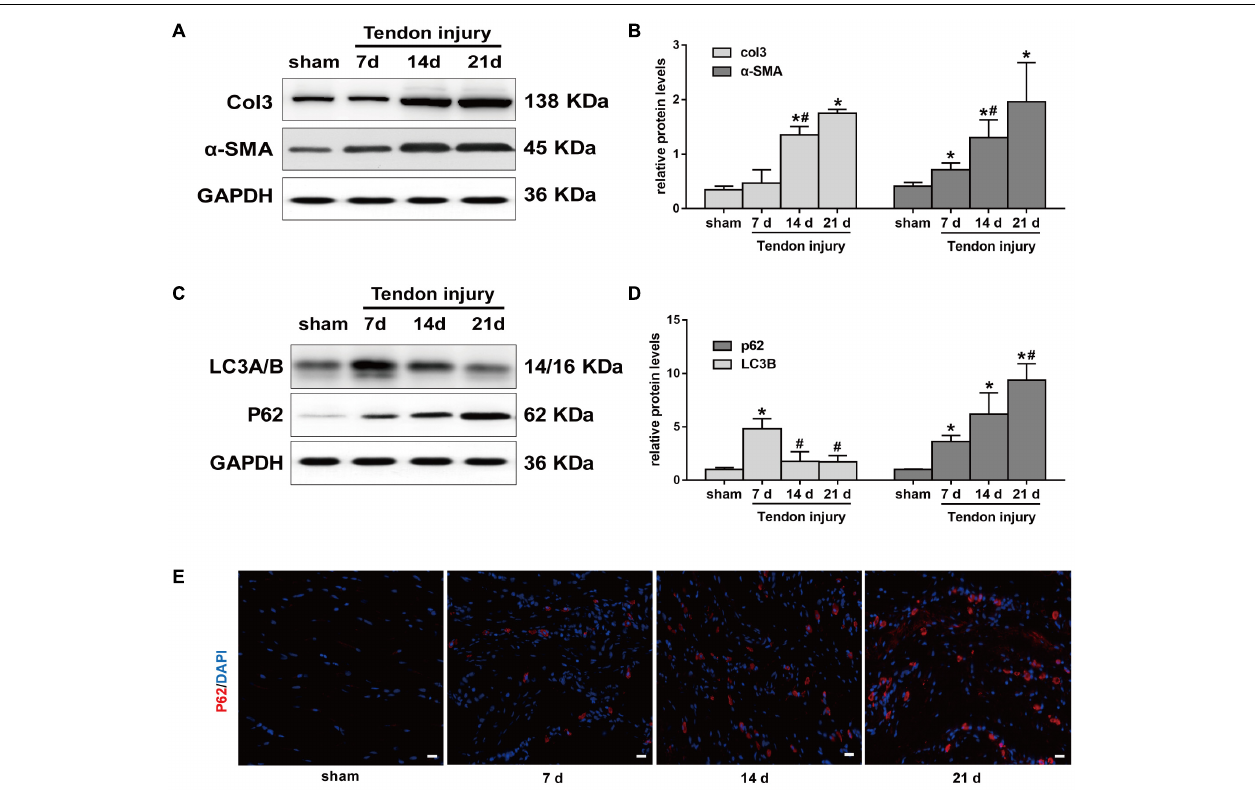
FIGURE 2 | Autophagy and fibrotic changes after tendon injury. (A) Representative images of western blot analysis of Col3 and α -SMA in sham operation (SO) and tendon injury (TI) rats. (B) Densitometry of Col1 and α -SMA expression. (C) Representative images of western blot analysis of LC3A/B and p62 in different groups. (D) Densitometry of Col1 and α -SMA expression. (E) Representative images of immunofluorescent staining for p62 in different groups. Scale bar: 20 µ m. n = 3 in each group. The data are shown as the mean ± SD. ∗ P < 0.05 compared with the SO group. # P < 0.05 compared with 7 days after